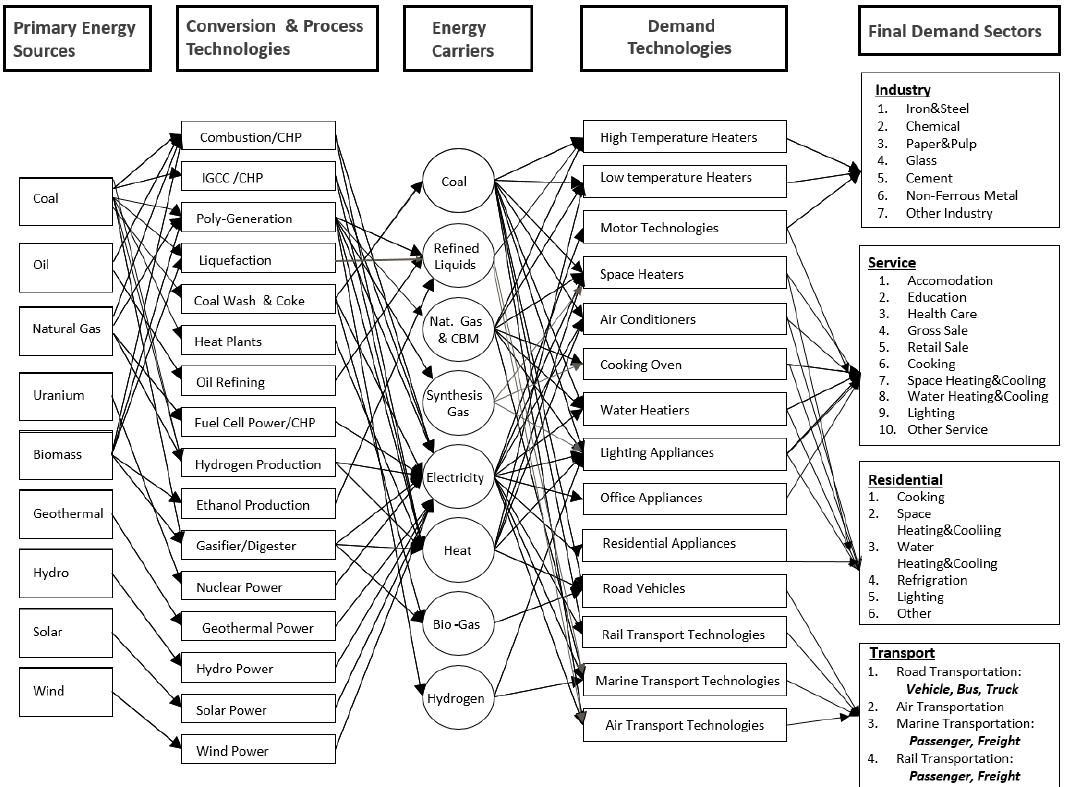
Figure 2. The BUEMS simplified reference energy system.